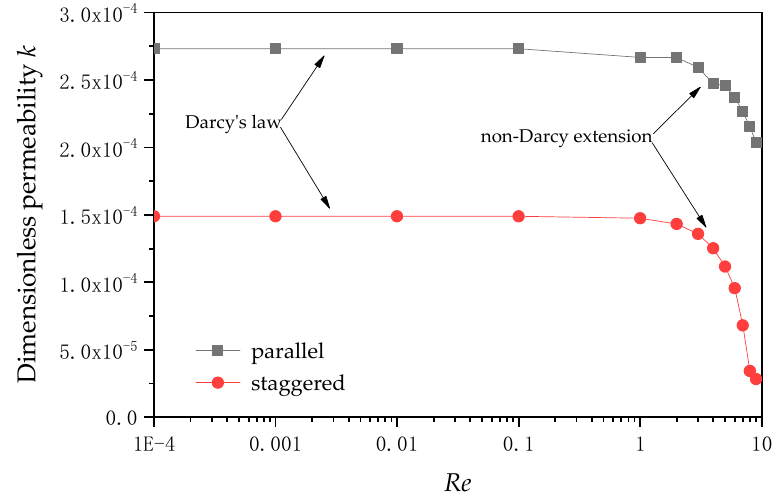
Figure 16. Relation between dimensionless permeability and Reynolds number of parallel and staggered structures.